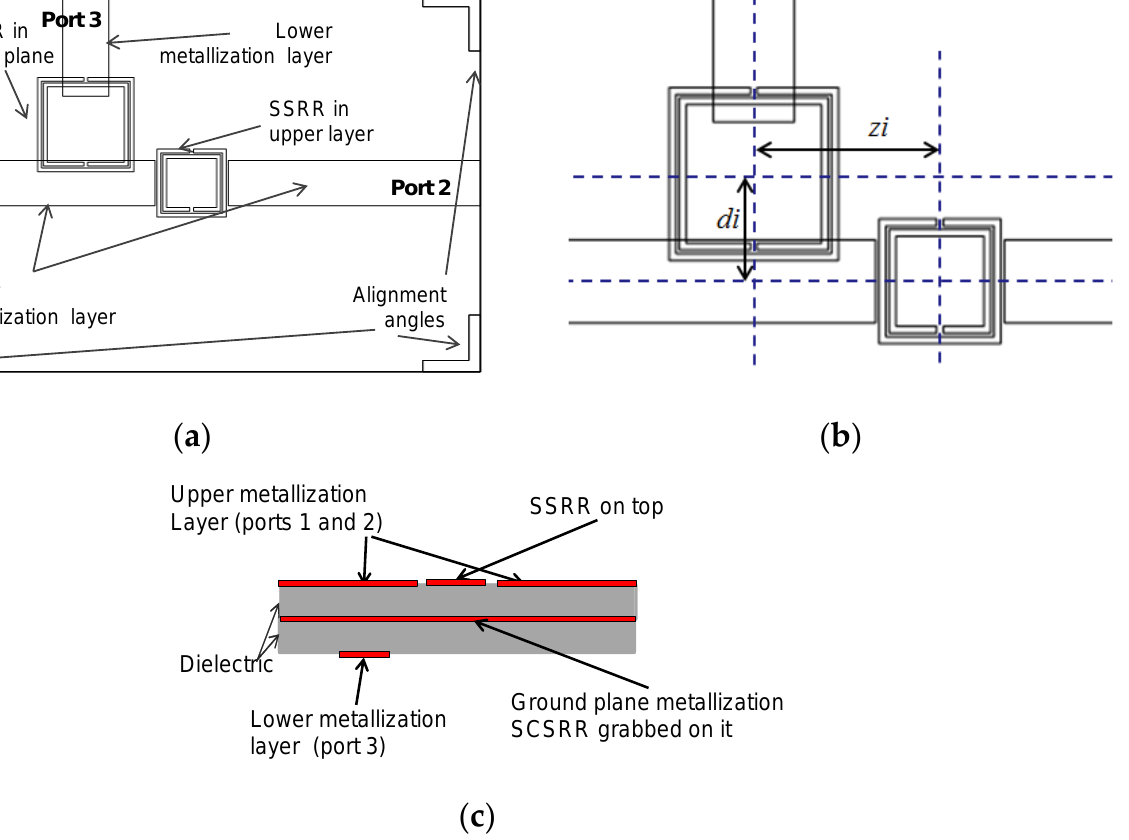
Figure 17. ( a ) Top view overlapped layer distribution of a 2-layer duplexer. ( b ) Relevant dimensions for the second resonator’s position. ( c ) Schematic representation of front view layer distribution. The dimensions of the SSRR placed in the upper layer are square side length l = 3.6